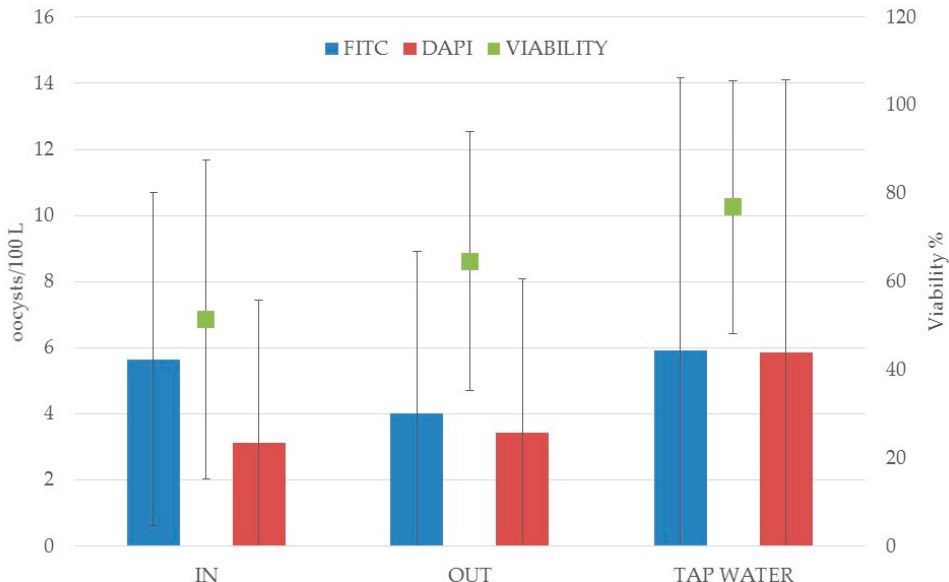
Figure 1. Mean and standard deviation (SD) of the concentration of Cryptosporidium spp. and number of oocysts viable at the different sampling points. The percentage of viable oocysts in the sample was calculated using DAPI staining.